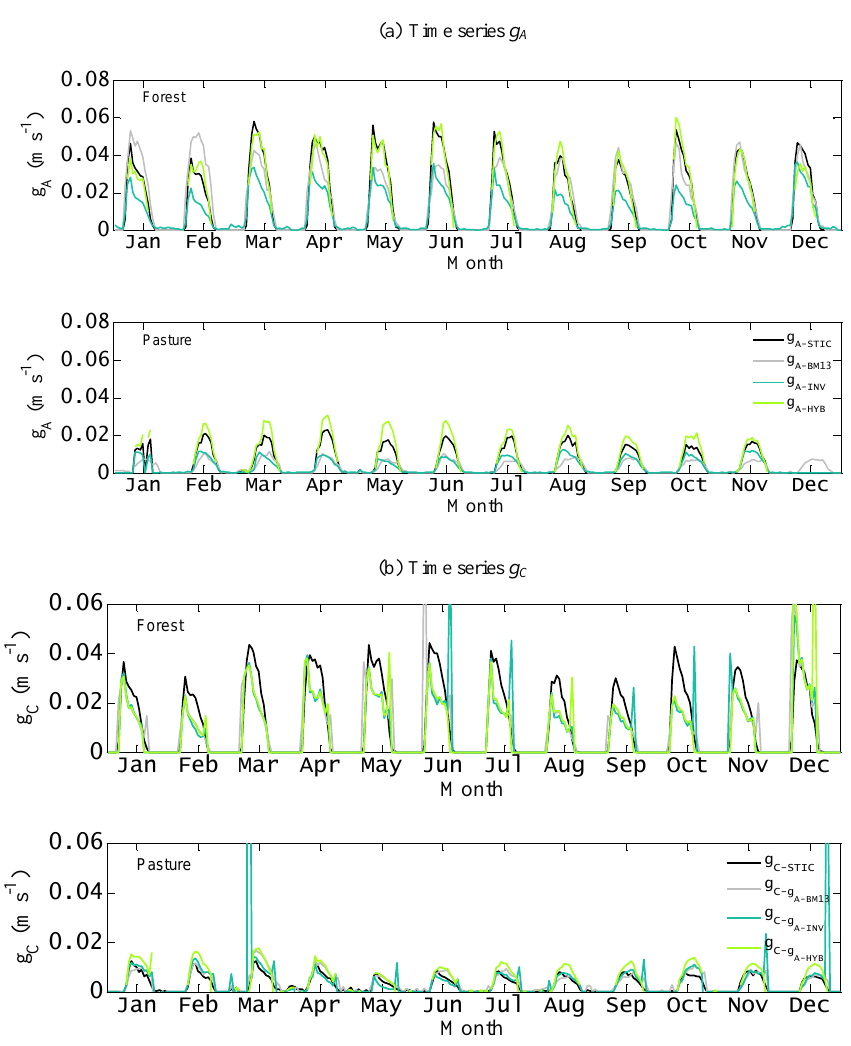
Figure 1. Examples of monthly averages of the diurnal time series of canopy-scale (a) g A and (b) g C estimated for two different biomes (forest and pasture) in the Amazon Basin (LBA sites K34 and FNS). The time series of four different g A estimates and their corresponding g C estimates are shown